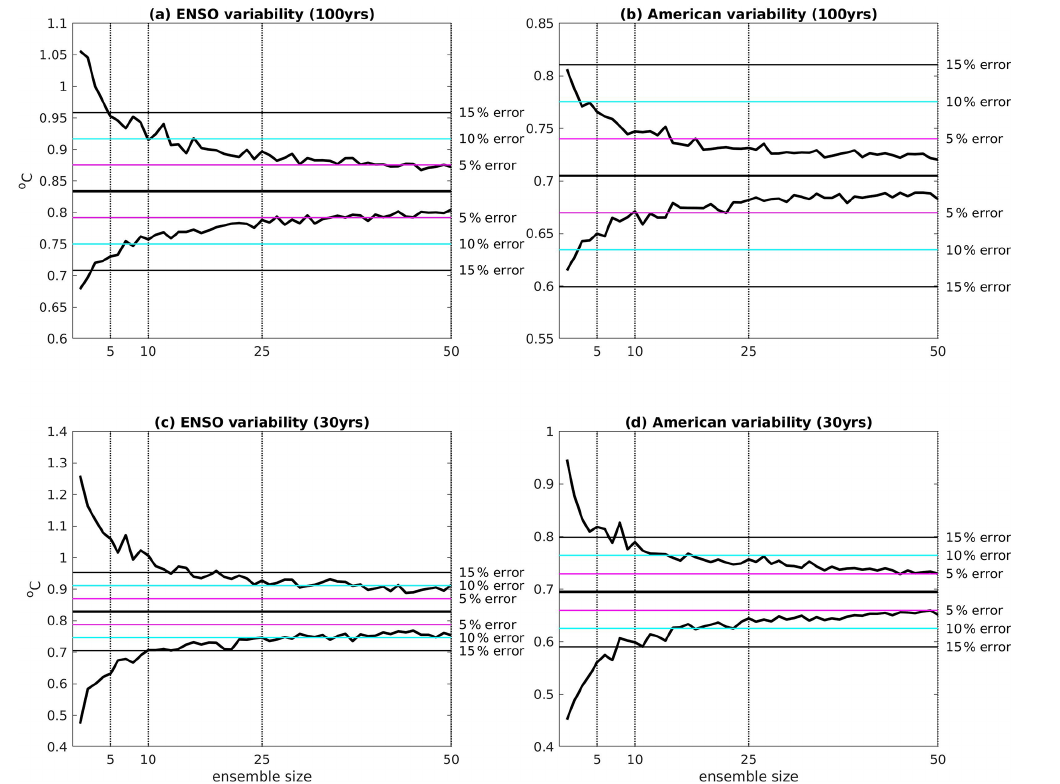
Figure 7. We show for increasing ensemble sizes the (a) ENSO variability in the Niño3.4 box (5 ◦ N–5 ◦ S, 170–120 ◦ W) calculated over 100-year periods, (b) central United States variability (34–46 ◦ N, 116–96 ◦ W) calculated over 100-year periods, (c) ENSO variability in the Niño3.4 box calculated over 30-year periods, and (d) central United States variability calculated over 30-year periods. All indices are calculated from the 2000-year MPI-GE control run. Each index is calculated as a running value at each time step in the control. ENSO indices are calculated for DJF, and United States indices are calculated for the annual mean. Ensembles of 1 to 120 members are created by randomly sampling the control simulation without replacement. For each ensemble size we create 1000 artificial ensembles. The estimated true value is calculated by using the entire 2000 years of the control and is shown as a horizontal black line. The maximum and minimum values of each index from the 1000 samples are shown as solid black lines. Varying error thresholds are shown as horizontal coloured